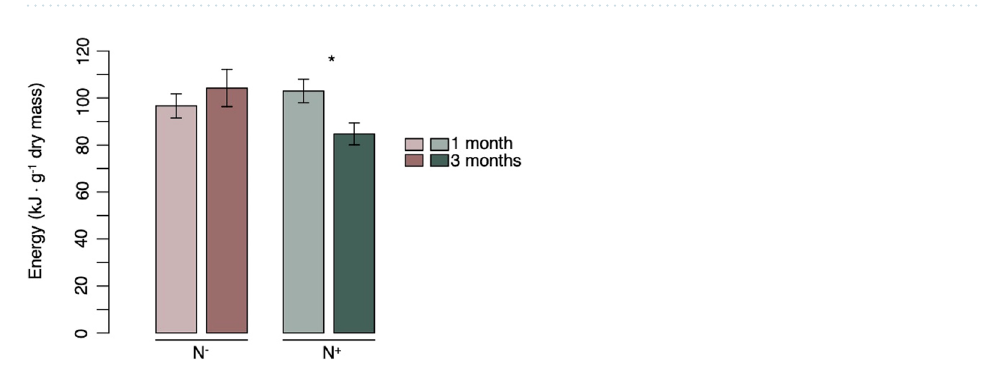
Figure 3. Effect of the interaction between salinity variation and nutrient enrichment through time on magnesium content in the shell of L. balthica . ( a ) Average magnesium content (mmol of Mg 2+ kg −1 dry mass) for salinity treatments (S) and nutrient concentrations (N) at one and three months of exposure in L. balthica . Pair-wise contrasts showed a significant difference between the two exposure times for different combinations of salinity variation and nutrient conditions (p < 0.05) as indicated by asterisks. Histograms represent mean values, and error bars correspond to standard errors. ( b ) Positive and negative antagonistic interaction between freshwater presses and nutrient enrichment through time based on a null additive model (yellow) (S + N). Single effects of stressors, compared to the least stressful conditions, are shown in light blue and gray and combined effect is shown in dark gray. Error bars correspond to standard errors.